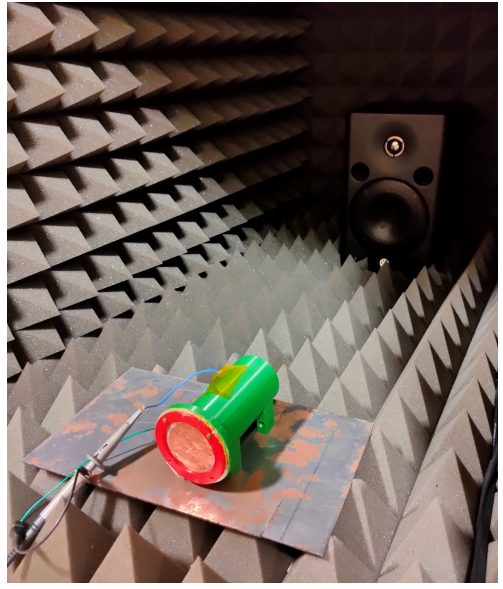
Figure 6. Triboelectric